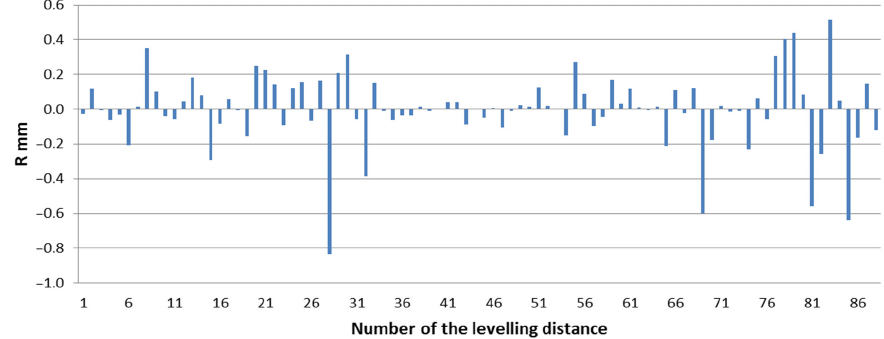
Figure 4. Refraction correction values for every leveling distance in fore leveling